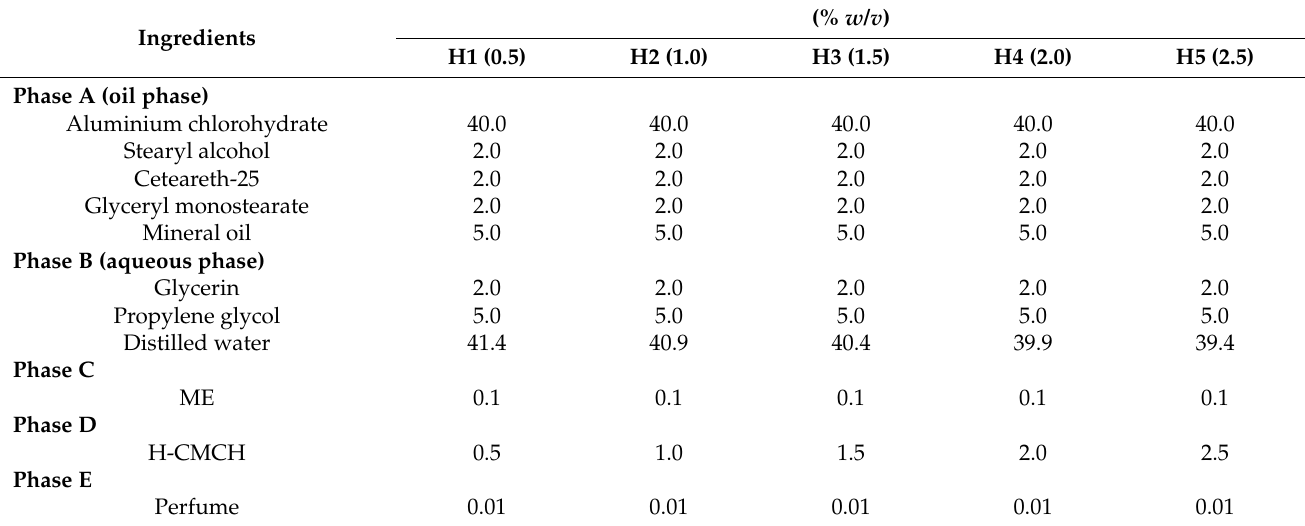
Table 1. Deodorant cream formulas with different content of H-CMCH (0.5, 1.0, 1.5, 2.0, and 2.5% ( w / v